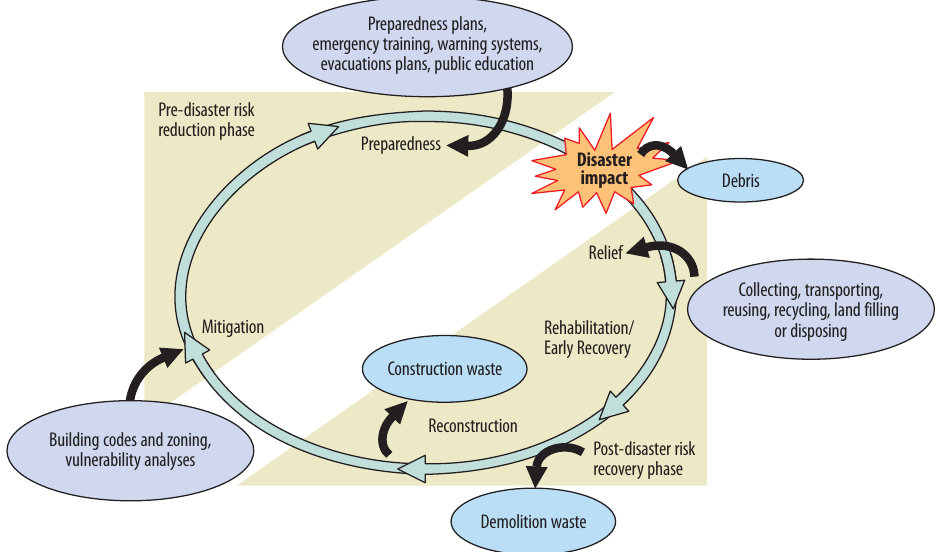
Figure 3. Relationship of disaster management cycle with disaster waste management (Source: DMC,